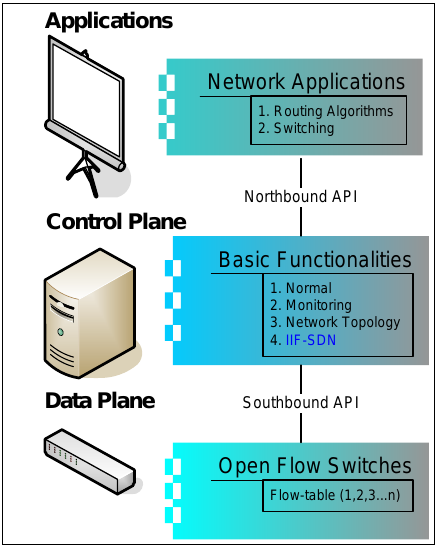
Figure 5. Structure of SDN with the IIF-SDN scheme.